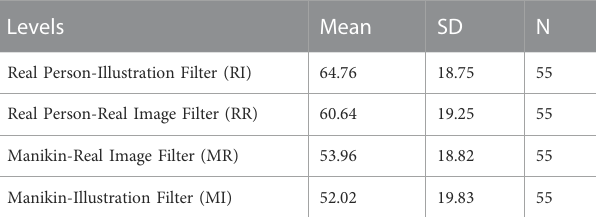
TABLE 2 Descriptive Statistics for noticing pattern ratings. Lower mean indicates noticing pattern changes sooner.